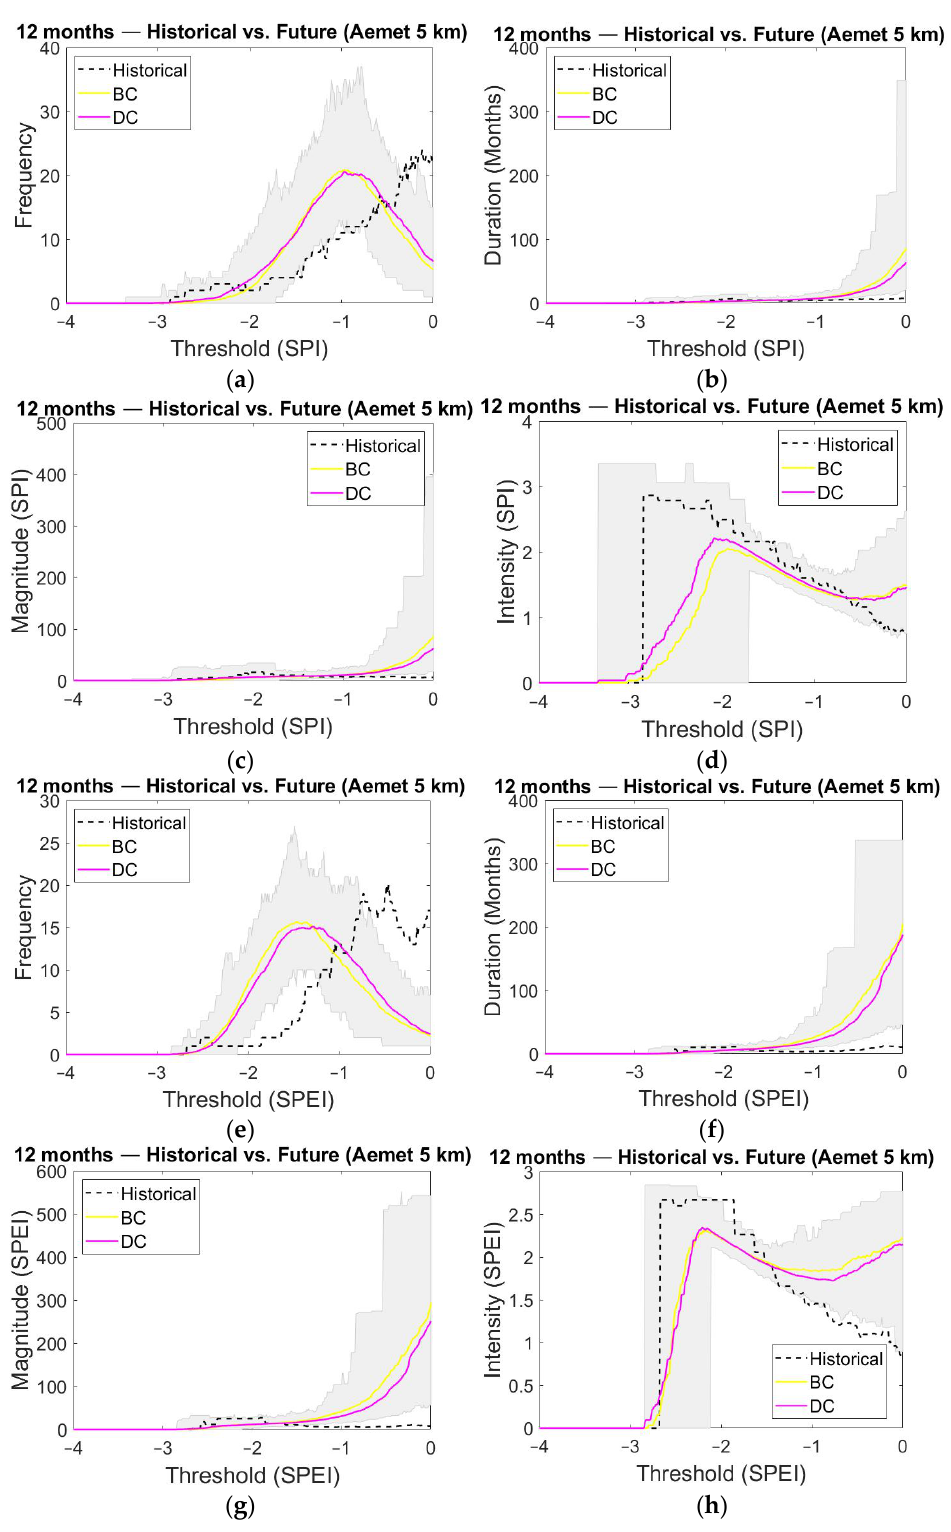
Figure A6. Historical and future meteorological drought ( a ) frequency; ( b ) mean duration; ( c ) mean magnitude; ( d ) mean intensity derived from SPI for the 12 months temporal-aggregation scale (Aemet 5 km database). Historical and future meteorological drought ( e ) frequency; ( f ) mean duration; ( g ) mean magnitude; ( h ) mean intensity derived from SPEI for the 12 months temporal-aggregation scale (Aemet 5 km